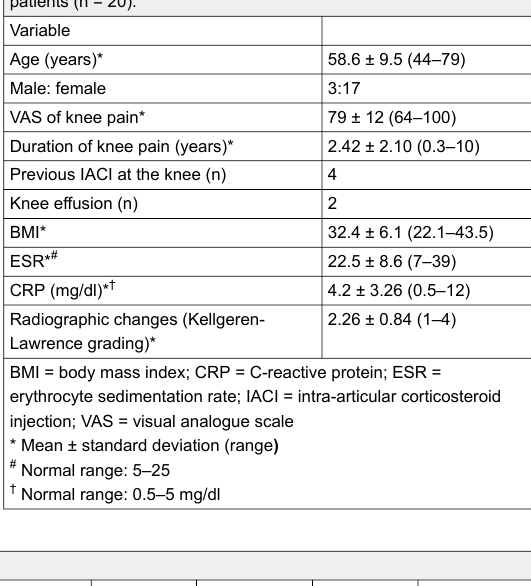
Table 2 : Serum cortisol levels at the various time-points in all individual patients. Time